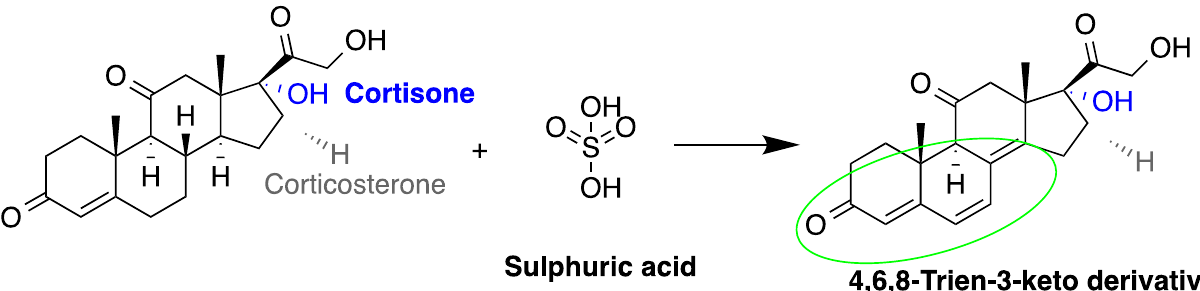
Figure 3. Fluorescence emission of steroids after treatment with sulfuric acid.